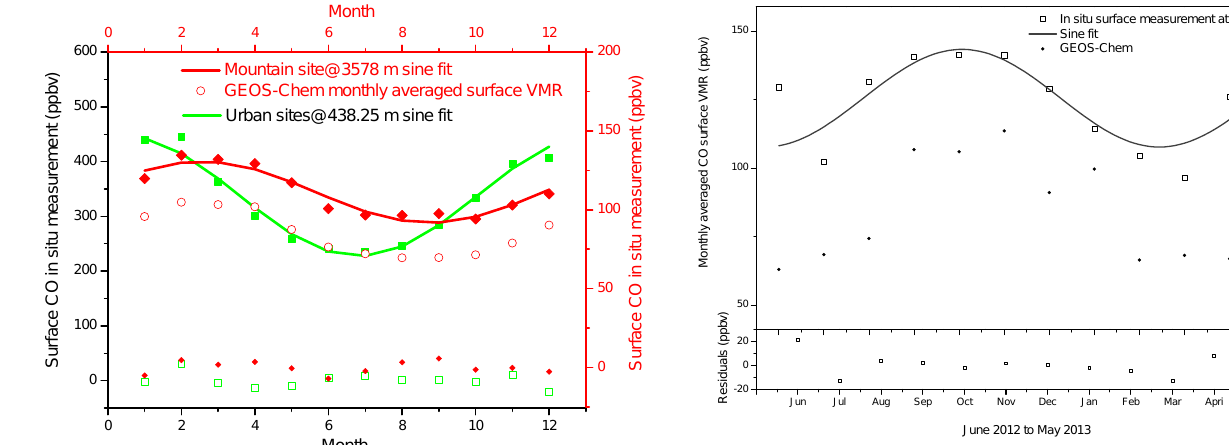
Figure 6. Monthly averaged CO in situ measurements at the sur- face in Switzerland using Swiss NABEL data from 2009 to 2013 (green squares are the means of the four urban sites and red di- amonds are for Jungfraujoch). The sine function fit is applied to the 5-year monthly means of urban (green line) and mountain (red line) sites. The two lowermost data sets show the residuals of the fit (green open squares for urban sites and red small diamonds for Jungfraujoch). Monthly averaged CO surface VMR from GEOS- Chem located at Jungfraujoch is shown in red open circles.